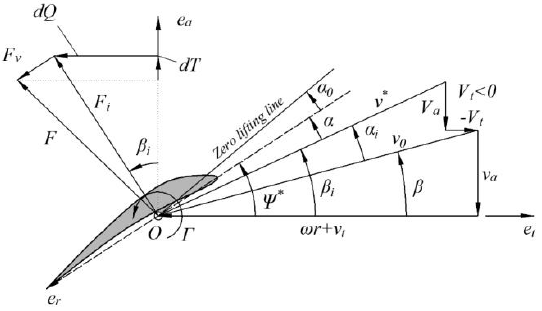
Figure 5. Force and velocity triangle at the control point on the lifting-line.